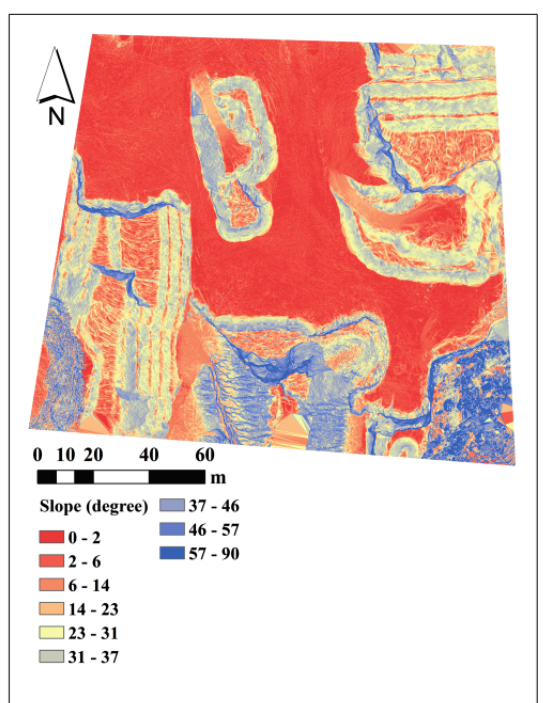
Figure 27. Classified slope map based on dataset